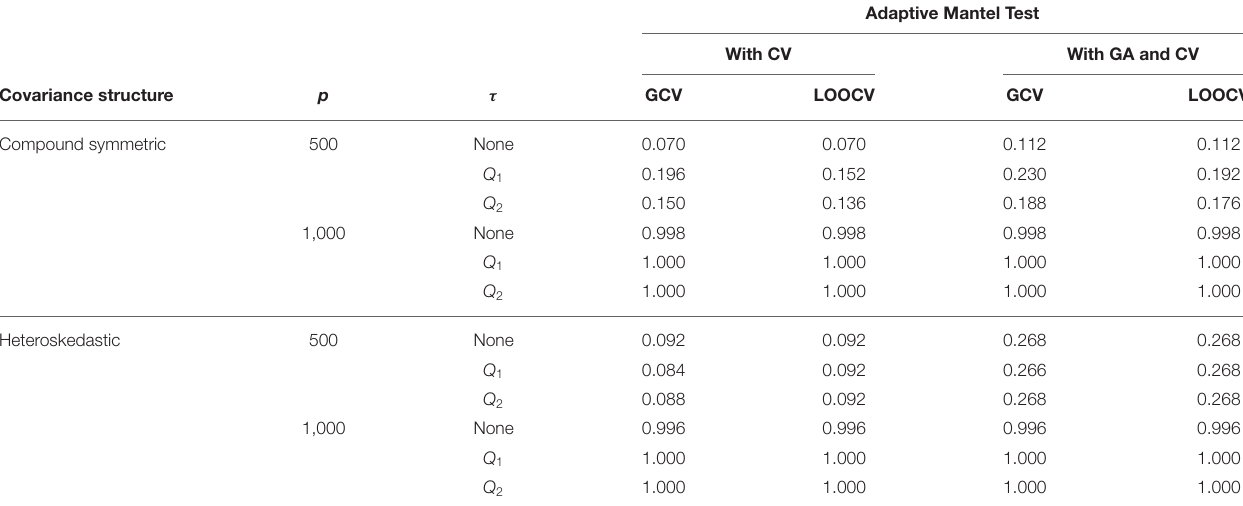
TABLE 3 | Numerical comparison of the Empirical Power of Adaptive Mantel test (i) with cross-validation vs. (ii) with Gamma approximation and cross-validation using the simulated data with n = 350, error standard deviation σ = 1 and b ∼ N ( 0 , σ 2 b I p ), σ b =